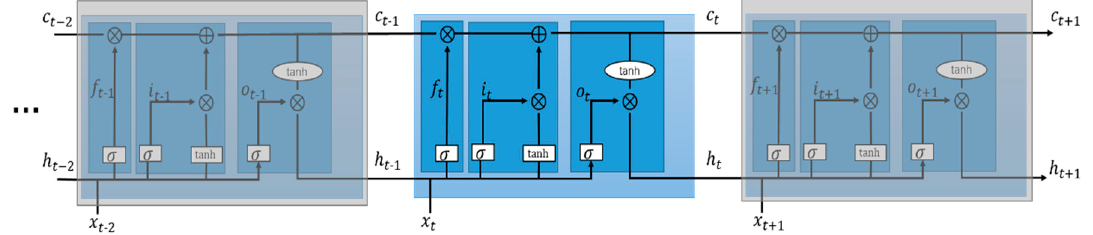
Figure 5. Network structure of LSTMs.